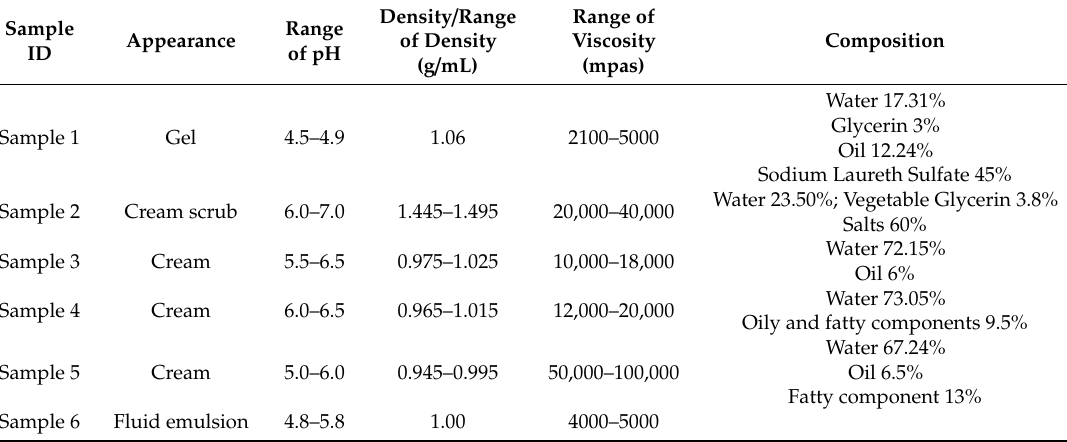
Table 1. Specifications and chemical physical state of cosmetics used.